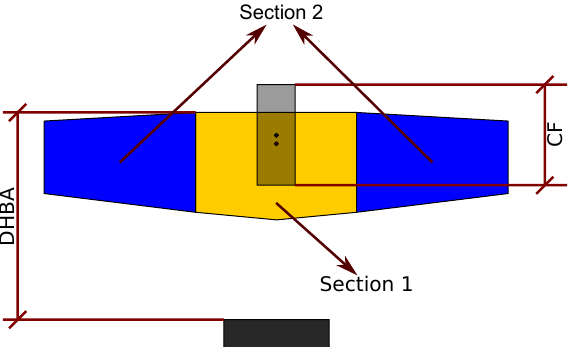
Figure 9. Schematic representation of the airplane. A set of parameters is shown: CF (fuselage chord), DHBA (horizontal distance between leading edges), and Section 1 (percentage of wingspan represented as A1, and tapper ration represented as